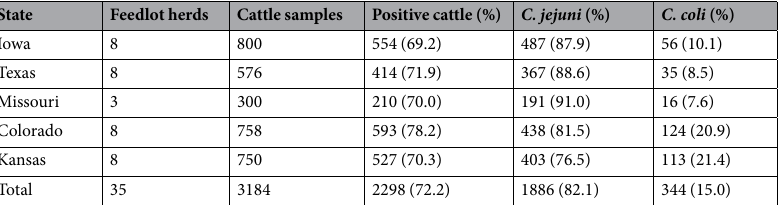
Table 1. Campylobacter species isolated from fecal samples of feedlot cattle from five states in the U.S.